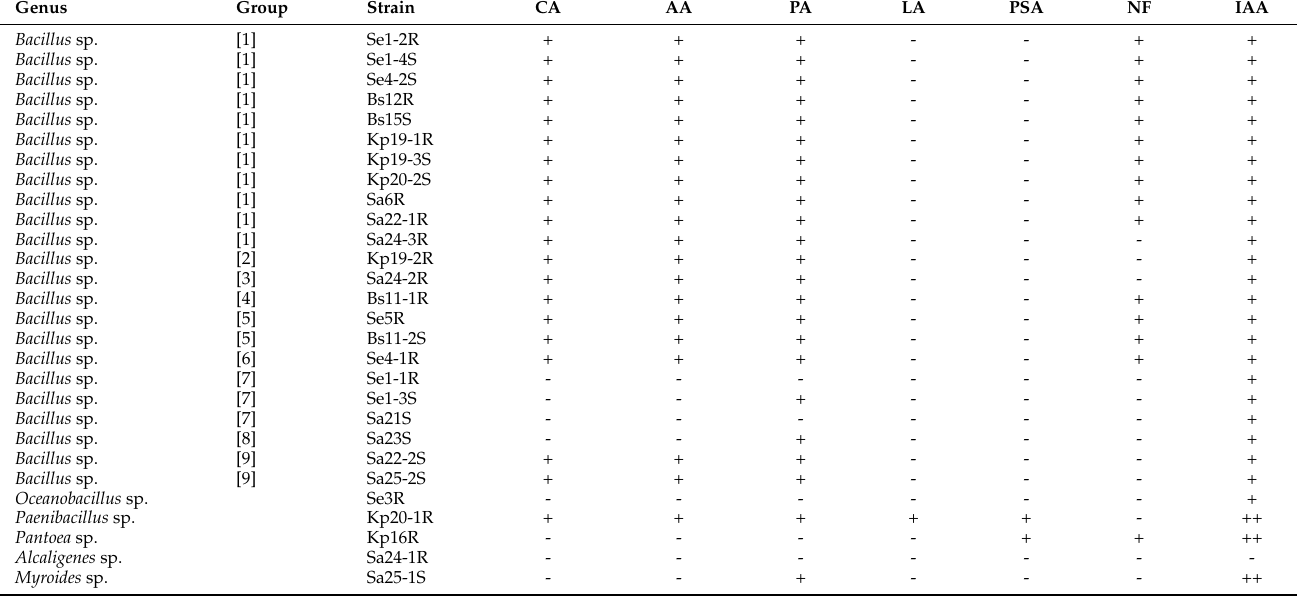
Table 4. Properties of